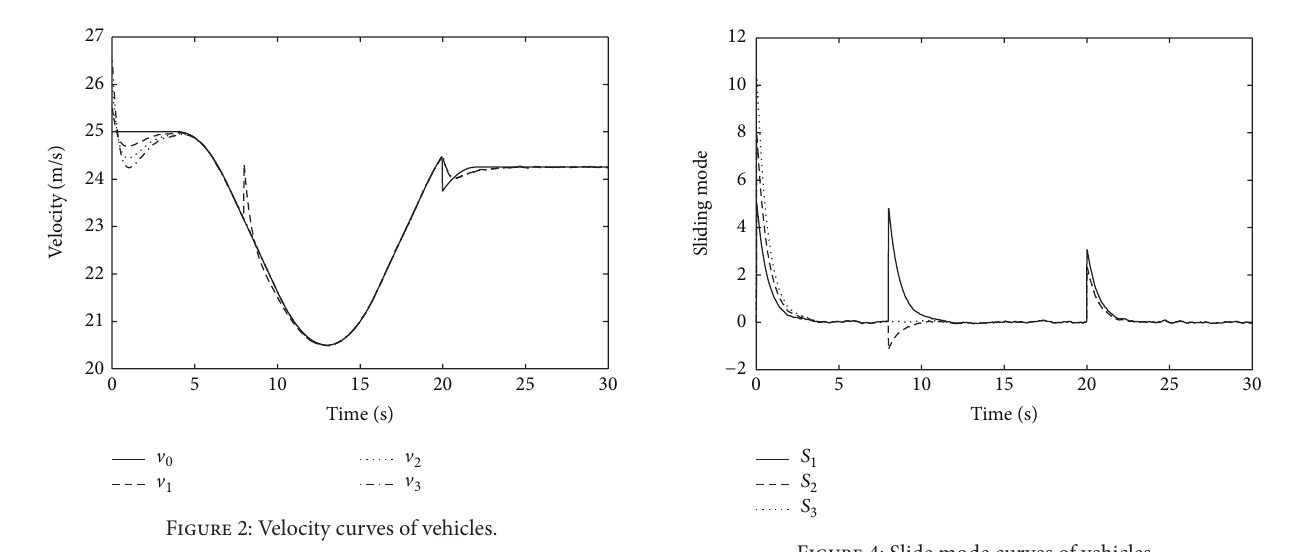
Figure 4: Slide mode curves of vehicles.